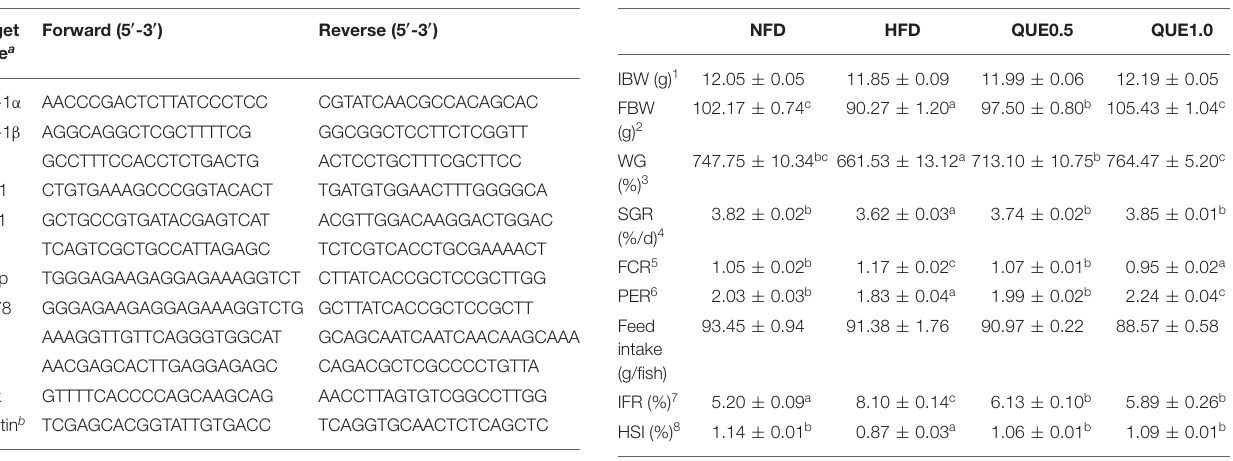
TABLE 3 | Growth performance of fish fed by the test diets for 8